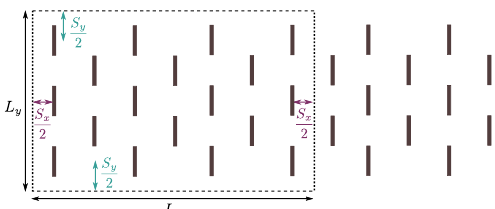
Figure 4. Schematic of a representative control volume used to calculate the resultant force for an array of devices. Here, L x and L y are the length and the width of the control volume, respectively; meanwhile, the height, L z , is the same as the channel. In this example, the control volume encloses 18 devices, and comprises a volume that includes from the first to the seventh row of turbines.